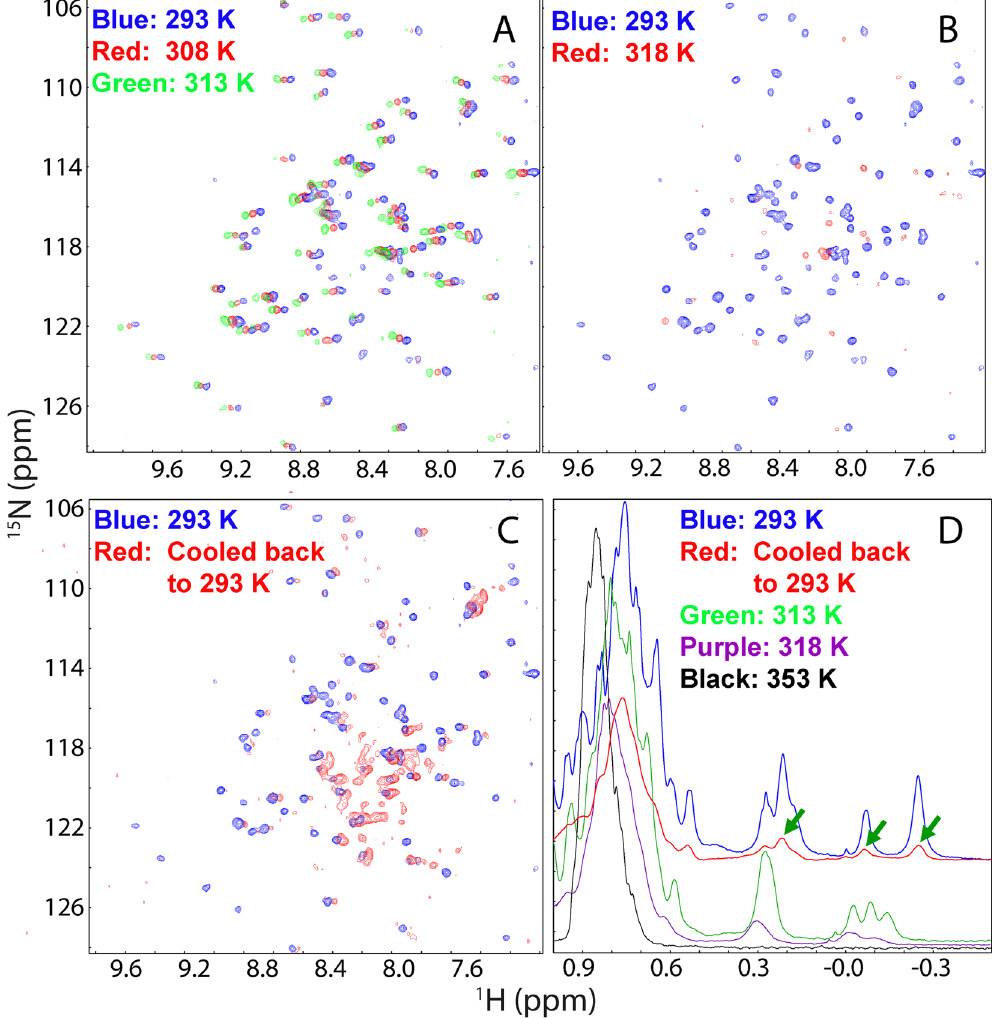
Figure 6. NMR characterization of the thermal unfolding of the FUS RRM domain. ( A – C ) 1 H- 15 N HSQC spectra of the FUS RRM domain at a concentration of 100 µ M in 10 mM phosphate buffer at pH 6.8 at different temperatures. ( D ) 1D 1 H spectra over − 0.5 – 1 ppm at different temperatures. Green arrows are used to indicate several very up-field peaks characteristic of the folded RRM